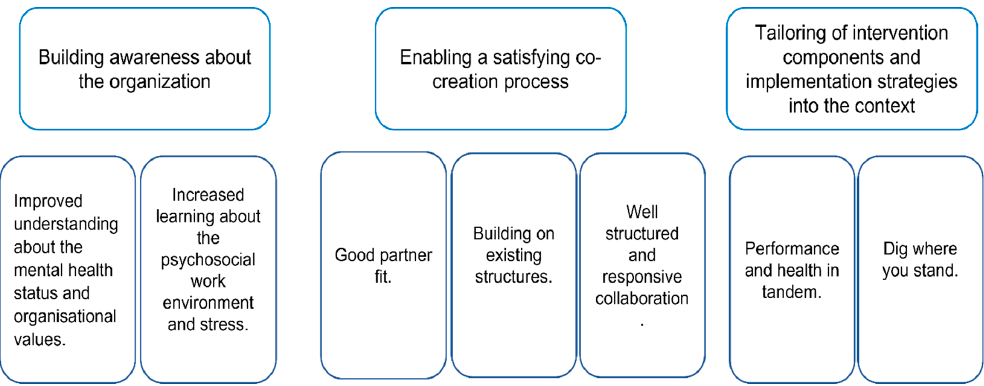
Figure 2. Themes and sub-themes describing respondents’ experiences of the co-creation and learning processes and perceptions of the intervention activities and implementation strategy.